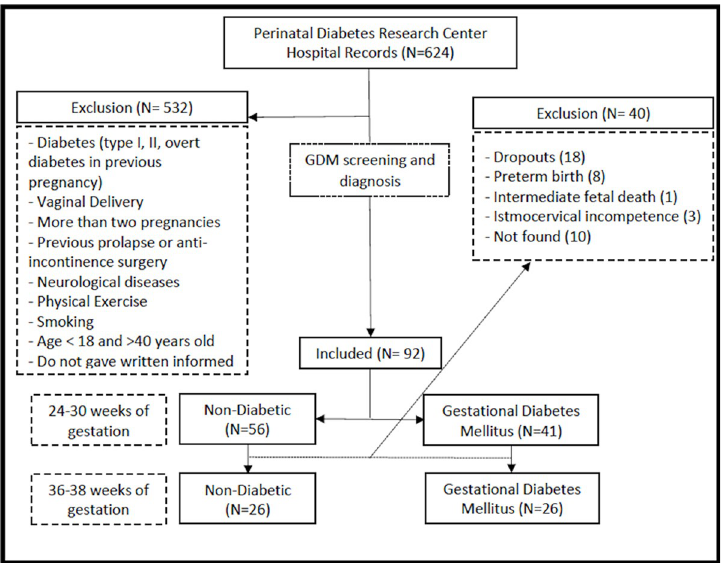
Fig 3. Flow diagram of GDM women’s screening, diagnosis, enrollment and follow-up